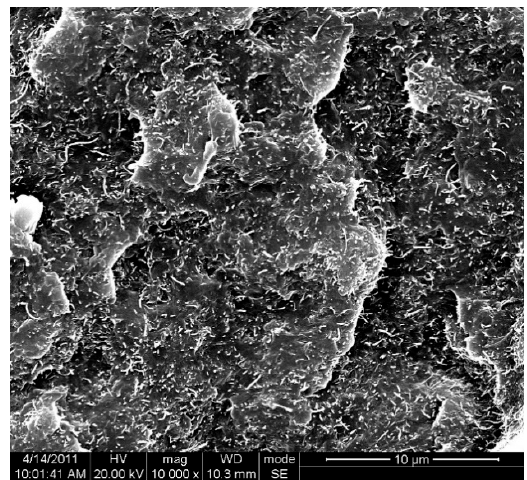
Figure 2. Photograph of the polyethylene sorbent surface.